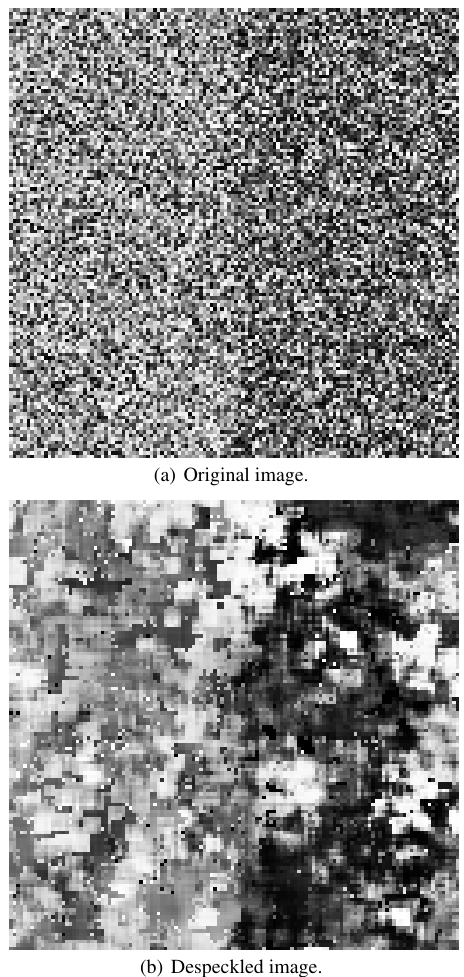
Figure 3. Result of applying the despeckling method using Shannon entropy.